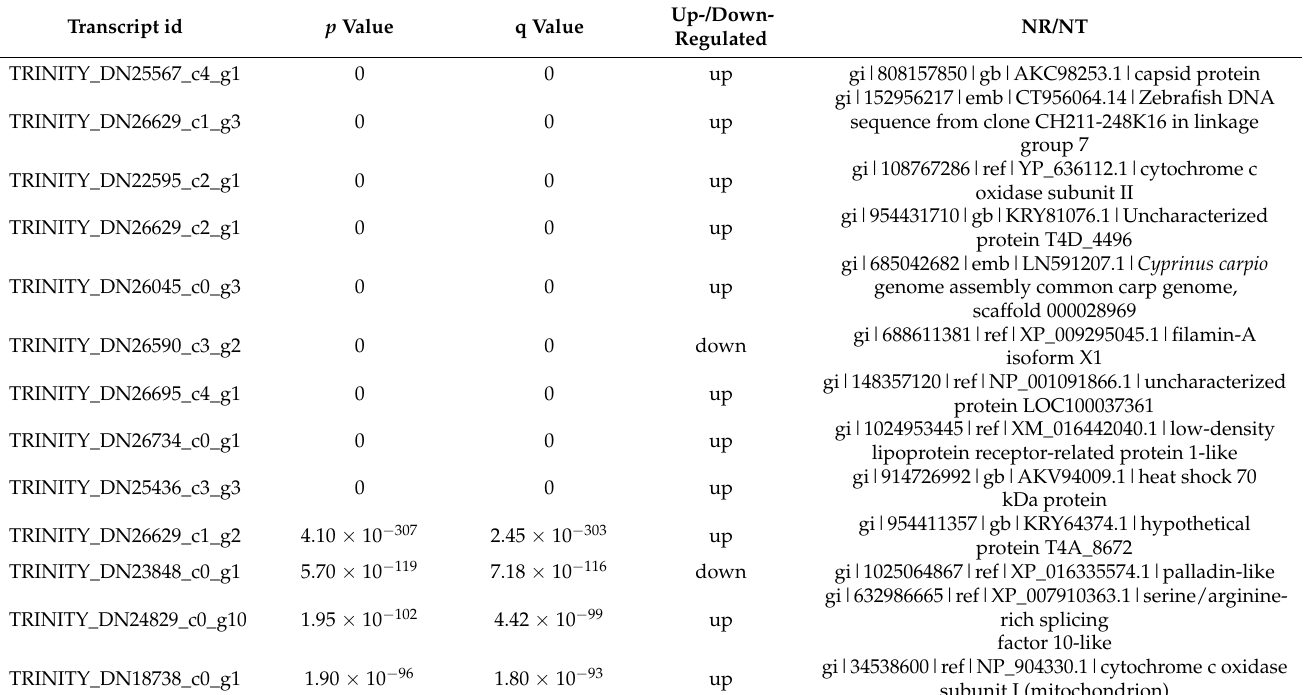
Figure 4. DE volcano and DE gene barplot after CP overexpression. CP1, CP2, and CP3 were at 12 h, 24 h and 48 h post-infection with pEGFP-CP, respectively; C1, C2, and C3 were tested at 12 h, 24 h and 48 h post-infection with pEGFP-N1 as control, respectively. Table 2. NR/NT annotation of the most significant DEGs.